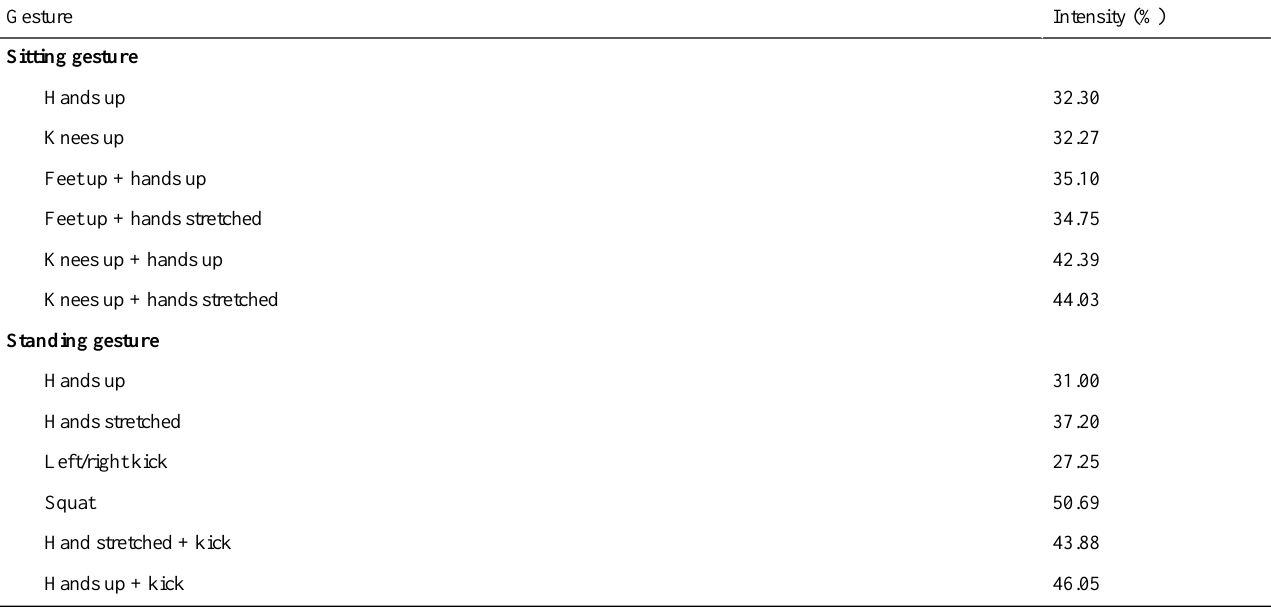
Table 1. Intensity level of the gestures used in the experiment.